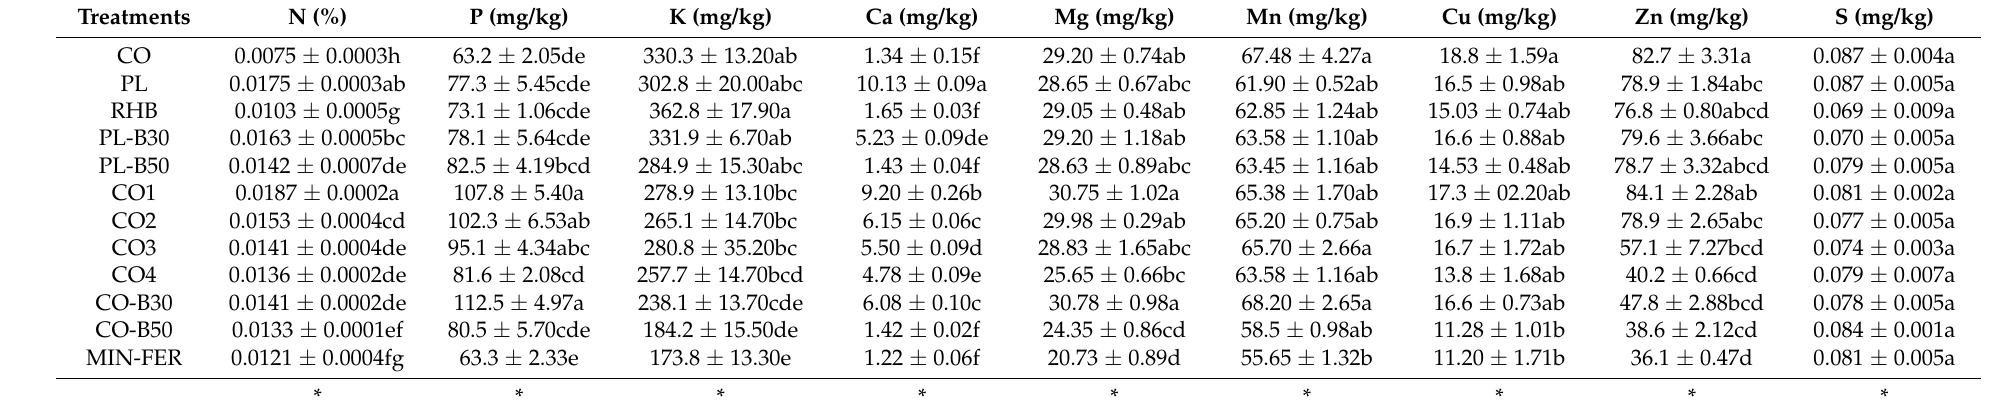
Table 8. Soil properties at